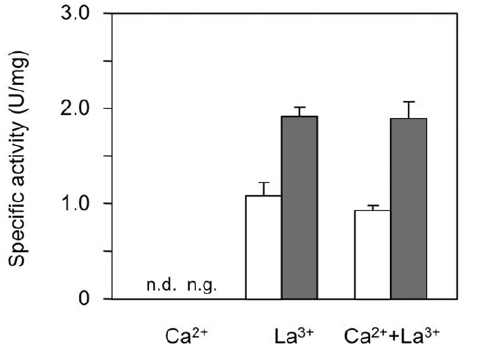
Figure 6. MDH activity in strain D mxaF grown on the methanol and succinate media with Ca 2 + and/or La 3 + . Cells were grown aerobically in succinate (white bar) and methanol (gray bar) media with 30 m M Ca 3 + , La 3 + , and Ca 2 + + La 3 + at 30 u C. n.d.: not detected, and n.g.: no growth. Results are shown as means with standard deviations ( n =3).